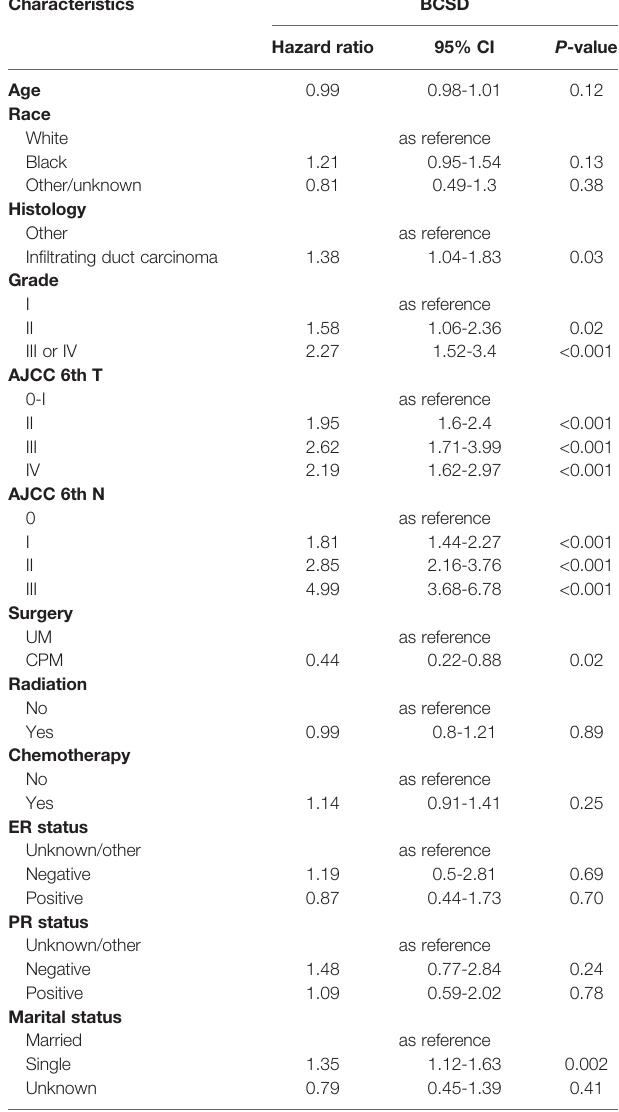
TABLE 4 | Competing risks regression of